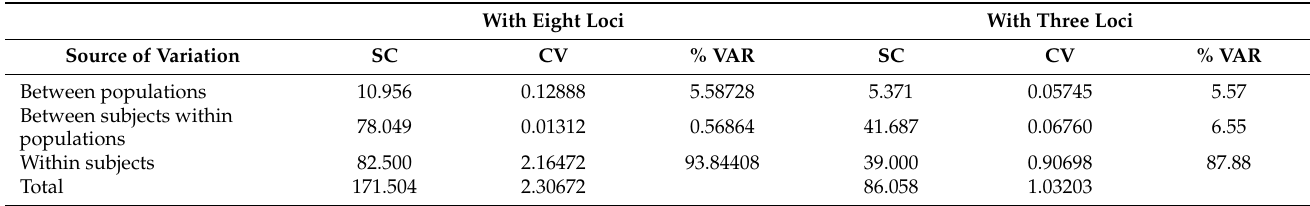
Table 4. Analysis of molecular variance (AMOVA) using eight loci and three amplified microsatellites.